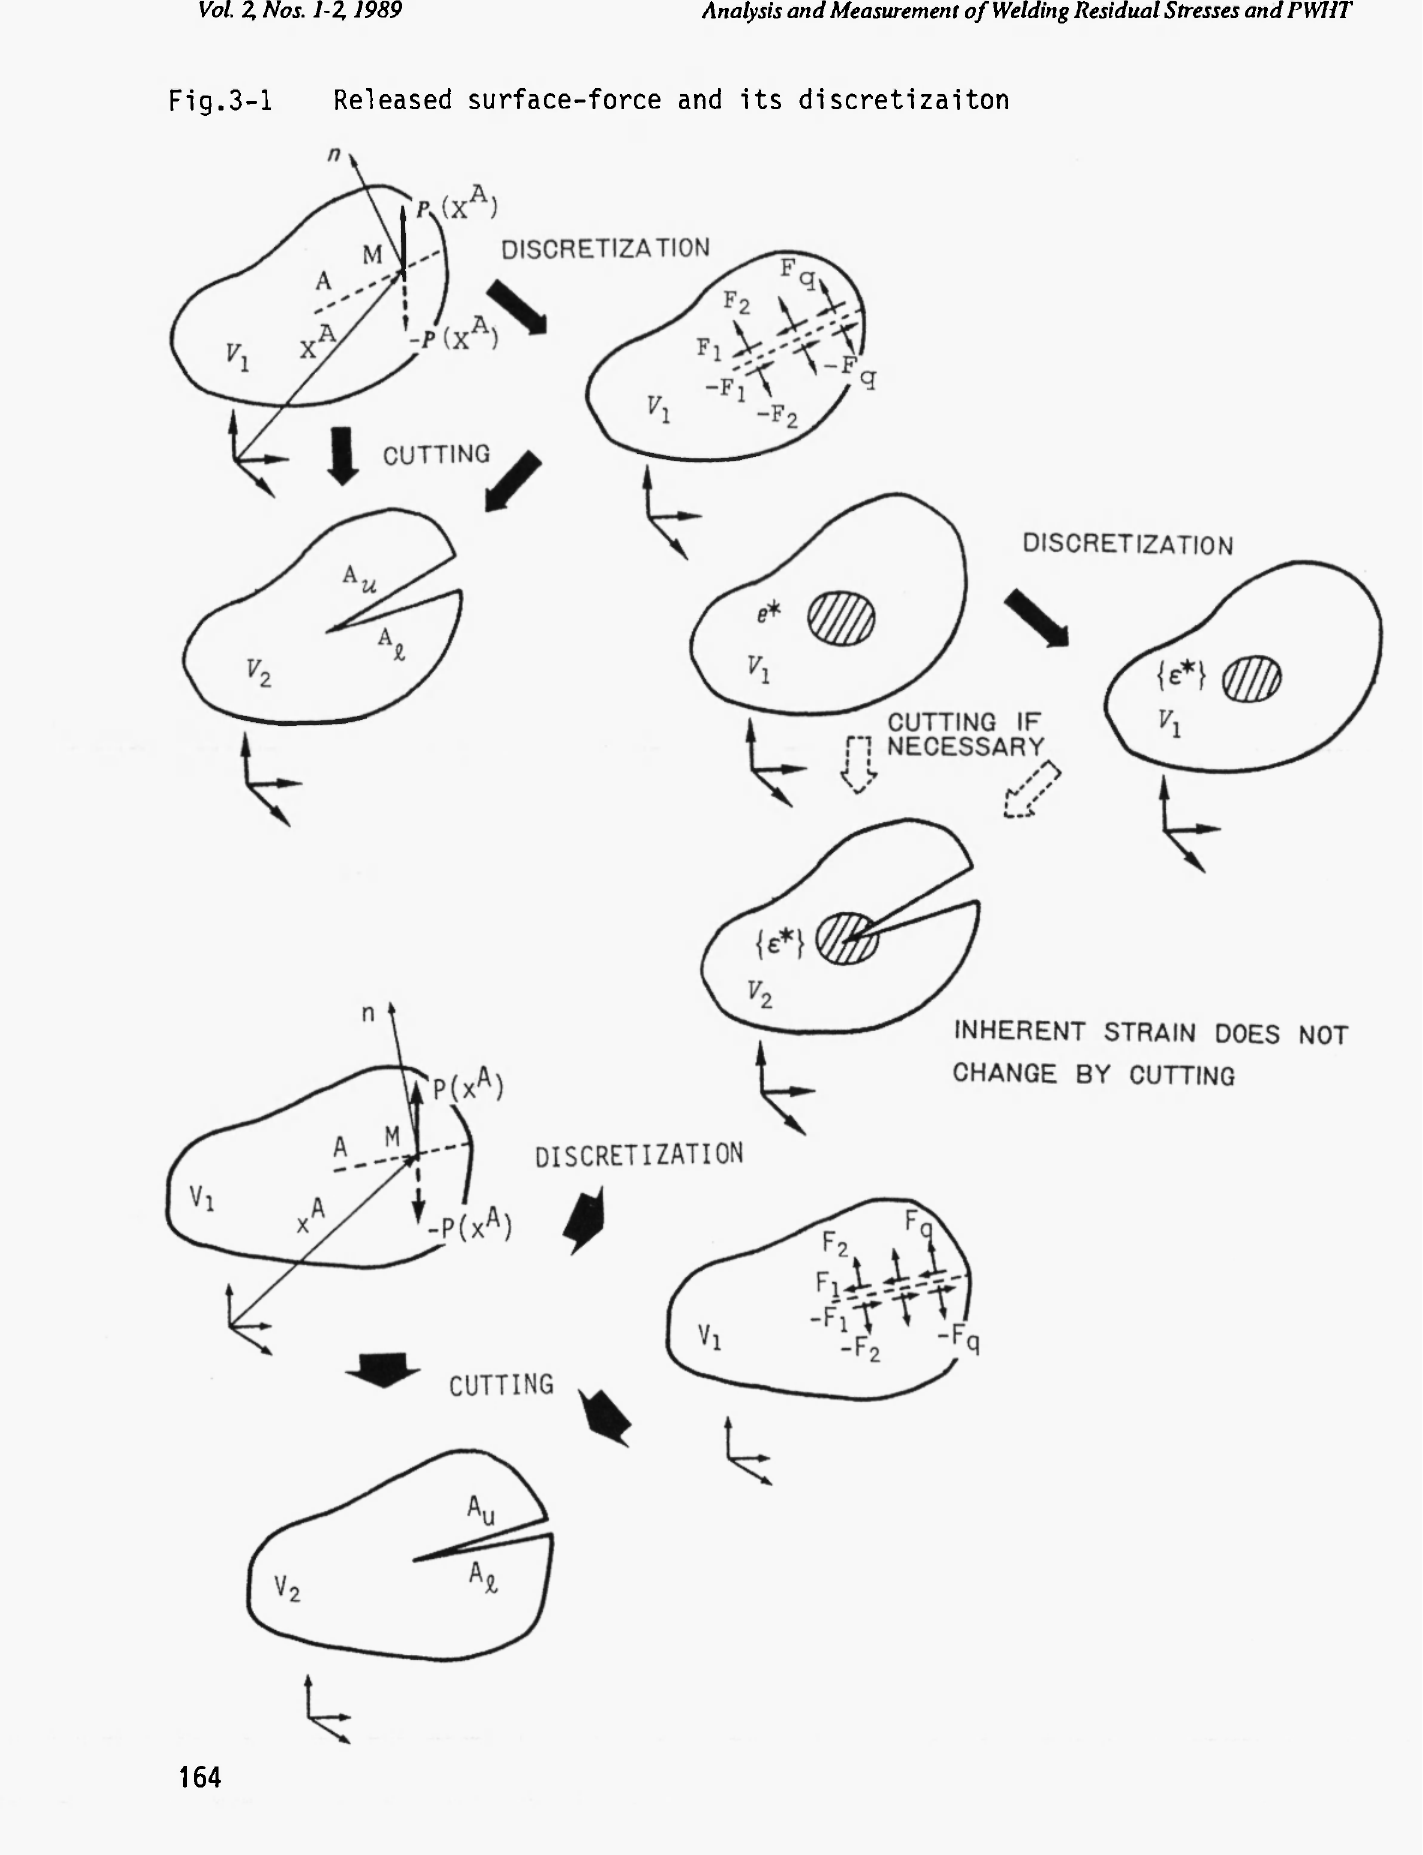
Fig.3-1 Released surface-force and its